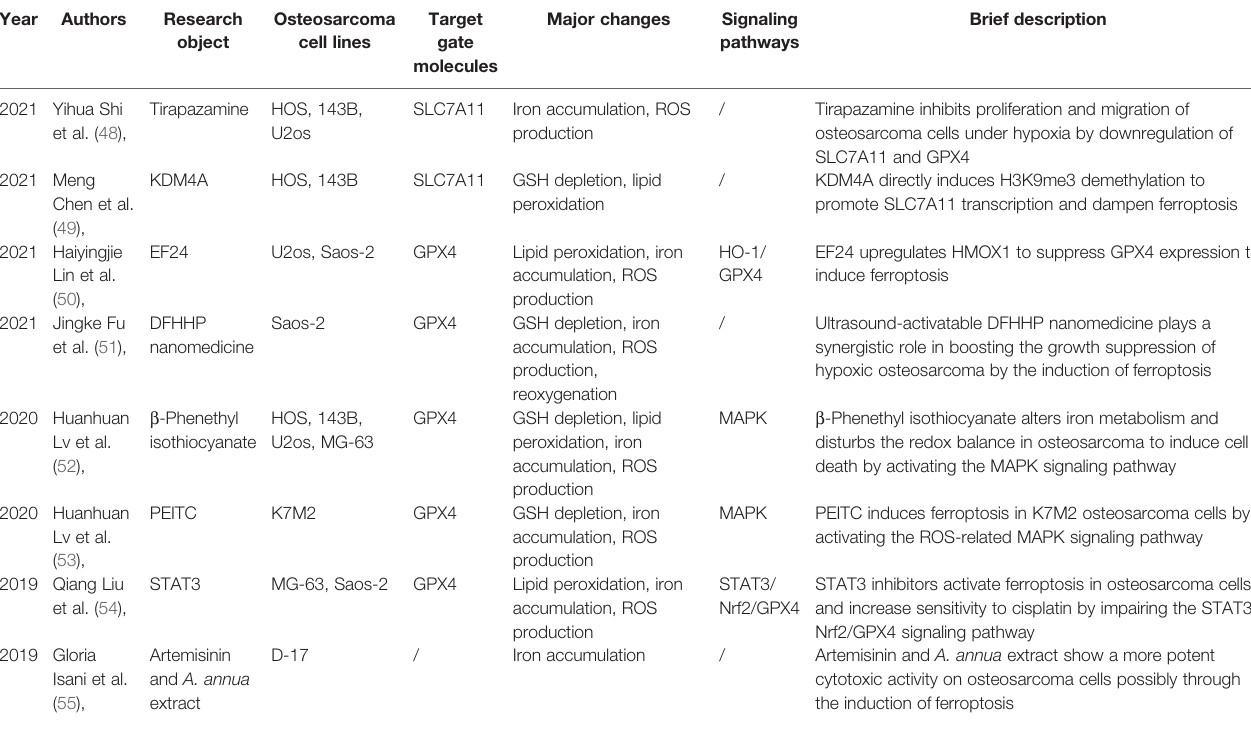
TABLE 1 | Previous published studies regarding ferroptosis in